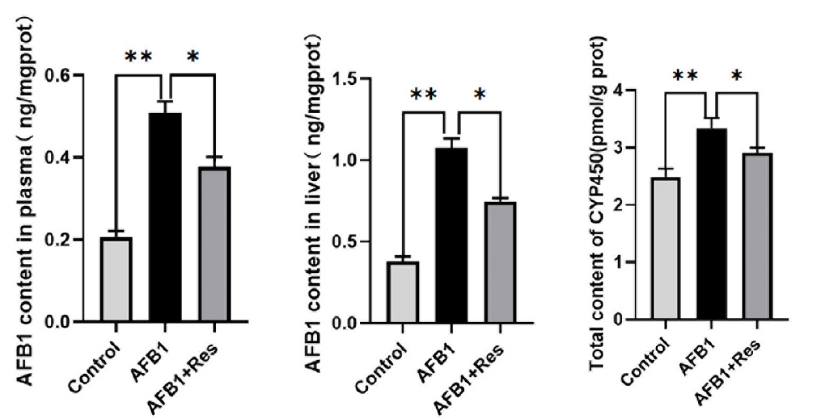
Figure 3. Effect of Res on the content of AFB1-DNA adduct and CYP450 content in the duck liver and plasma exposed to AFB1. Values are expressed as Mean ± SEM ( n = 6), and * means p < 0.05, ** means p < 0.01 .